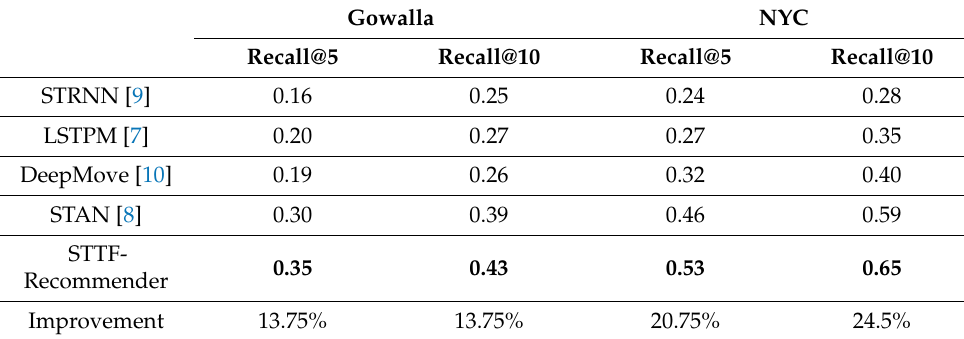
Table 3. Recommendation Performance Comparison with